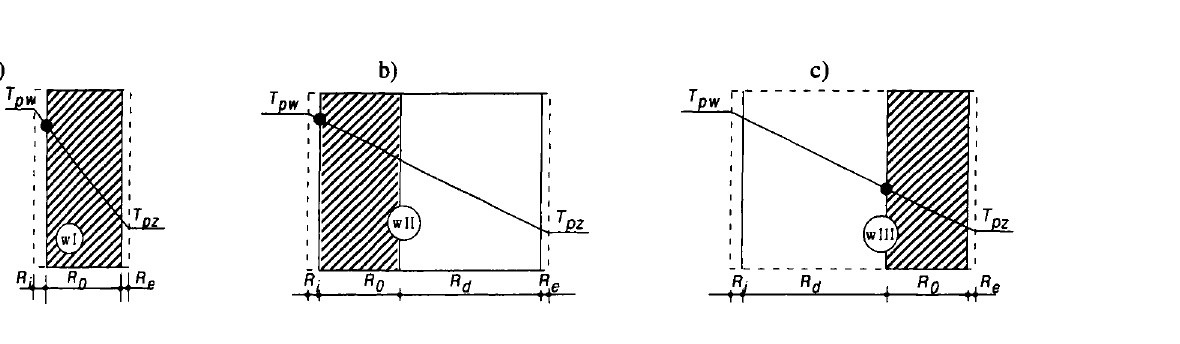
Fig 1. The graph illustrating the modifications in thermal properties of the partition: a - the partition before adding on thermal insulation (wl), b- traditional external insulation (wii), c- untypical "fictitious" heat insulation; change in the